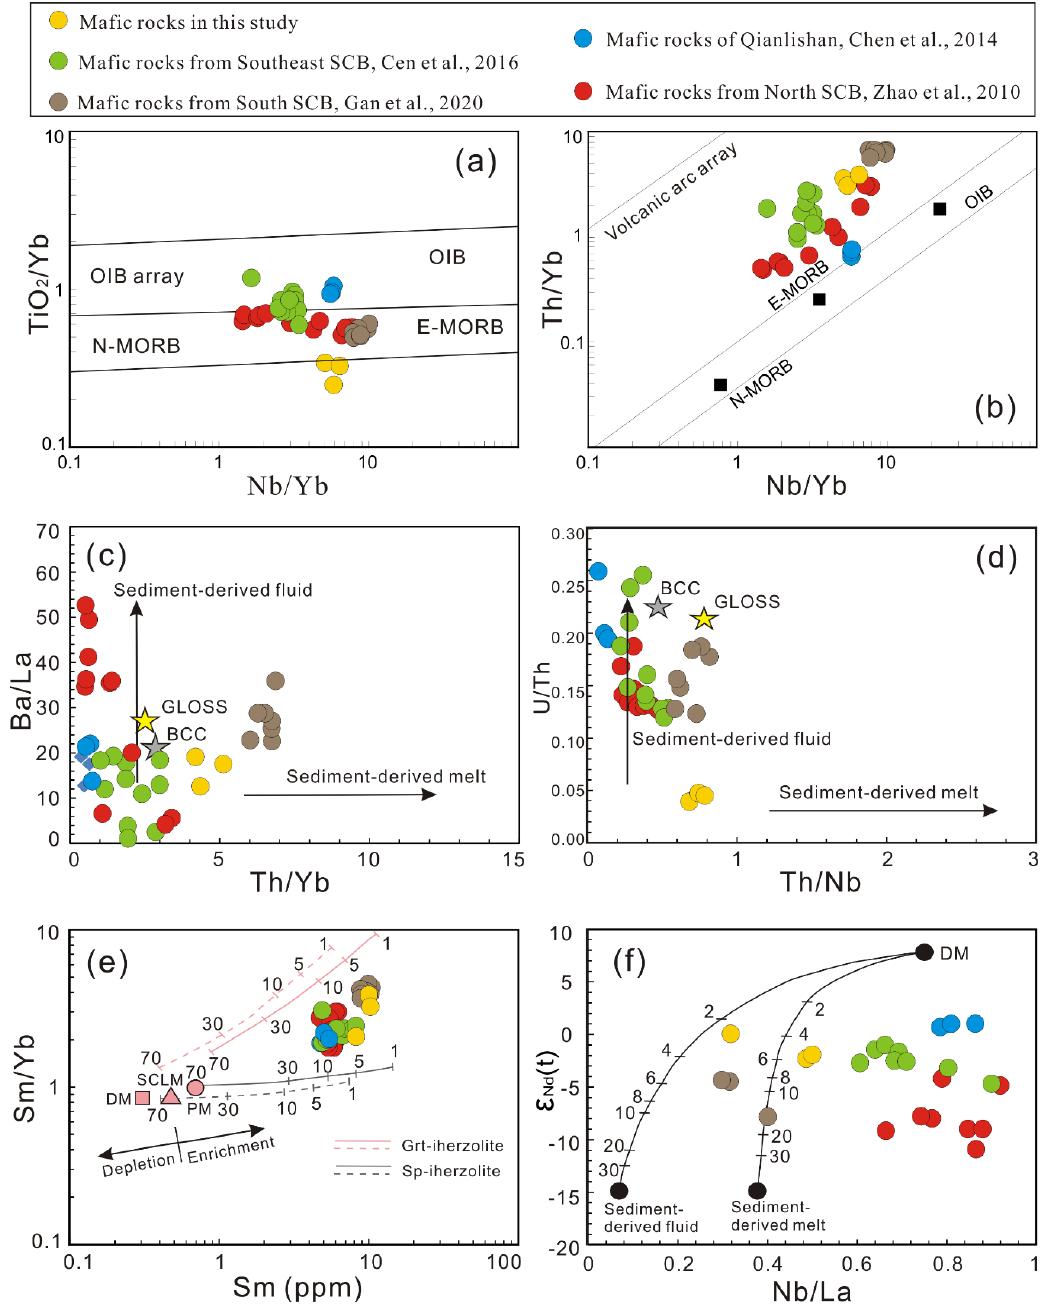
Figure 14. Plots of ( a ) TiO 2 /Yb vs. Nb/Yb, ( b ) Th/Yb vs. Nb/Yb [94], ( c ) Ba/La vs. Th/Yb, ( d ) U/Th vs. Yh/Nb, ( e ) Sm/Yb vs. Sm, and ( f ) ε Nd(t) vs. Nb/La [39] for the Qianlishan and the SCB mafic rocks: cited data are the same as in Figure 11. Normal mid-ocean ridge basalts (N-MORB), enriched mid-ocean ridge basalts (E-MORB), and oceanic island basalts (OIB) of (b) are cited from [94]. The fields of the global subducting sediment (GLOSS) and bulk continental crust (BCC) in (c,d) are from Plank and Langmuir [92]. The dashed and solid lines of (e) are melting trends for the DM (Sm = 0.3 ppm and Sm/Yb = 0.86 [95]) and the SCLM (Sm = 0.6 ppm and Sm/Yb = 0.96 [96]). The DM of (f) is represented by La = 0.4 ppm, Nb = 0.3 ppm, Nd = 4.0 ppm, and ε Nd(t) = +8 [97]; sediment-derived fluid is represented by La = 37.5 ppm, Nb = 2.25 ppm, Nd = 75 ppm, and ε Nd(t) = − 15; and sediment-derived melt is represented by La = 47.6 ppm, Nb = 17.8 ppm, Nd = 51.4 ppm, and ε Nd(t) = − 15 [98].